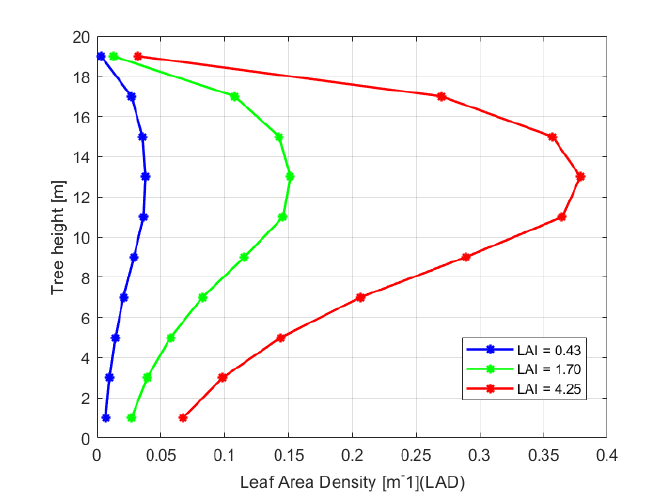
Figure 1. LAD distribution of individual trees in the respective forest cases considered. The LAI of the LiDAR data originally has a mean value of approximately 0.43. Then, the data were rescaled with a factor of 4 and 10 to generate two more cases of real forests having their mean LAIs matching with the corresponding case of homogeneous forests (see Table 1). The three-dimensional distribution of the forest properties showed a very high heterogeneity in the data. Trees of thick canopies and sparse trunk space are equally contained in the data. The maximum height of the trees contained in the data is 20 m.